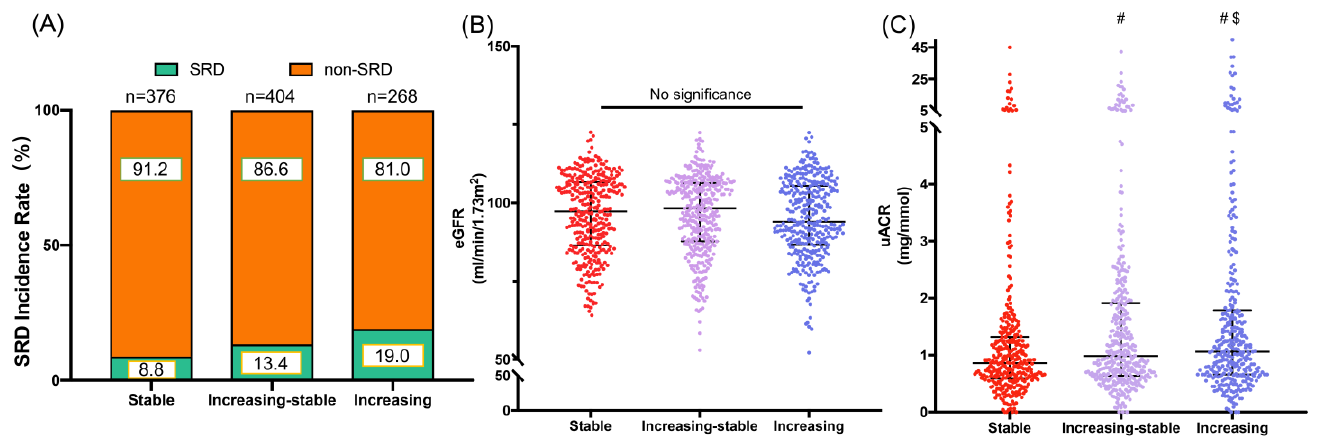
Figure 5. Renal damage of different trajectories groups. ( A ) SRD incidence rate among the three SRD risk score trajectory groups. ( B , C ) Scatter diagrams of eGFR levels and uACR levels among these three SRD risk score trajectory groups. SRD, subclinical renal damage; eGFR, estimated glomerular filtration rate; uACR, urinary albumin-to-creatinine ratio. # p < 0.05 vs. stable group and $ p < 0.05 vs. increasing-stable group. Table 3. Adjusted odds ratios and 95% confidence intervals of the association of SRD risk score trajectory groups with subclinical kidney damage.